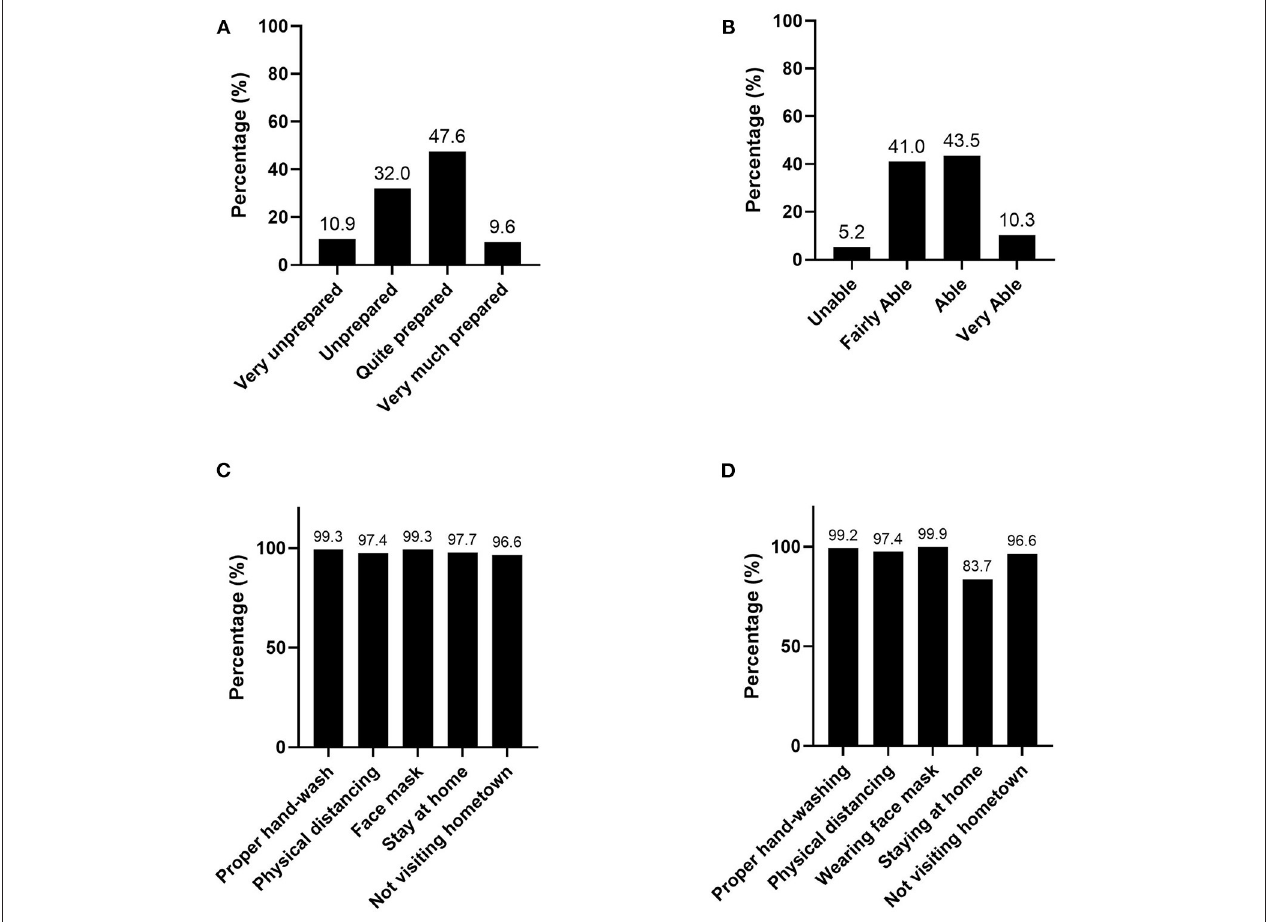
FIGURE 3 | Perception on: (A) Preparedness; (B) Ability to control the risk; (C) Efficacy of Control Measures; and (D) Willingness to carry out measures of COVID-19 in Indonesia ( n =